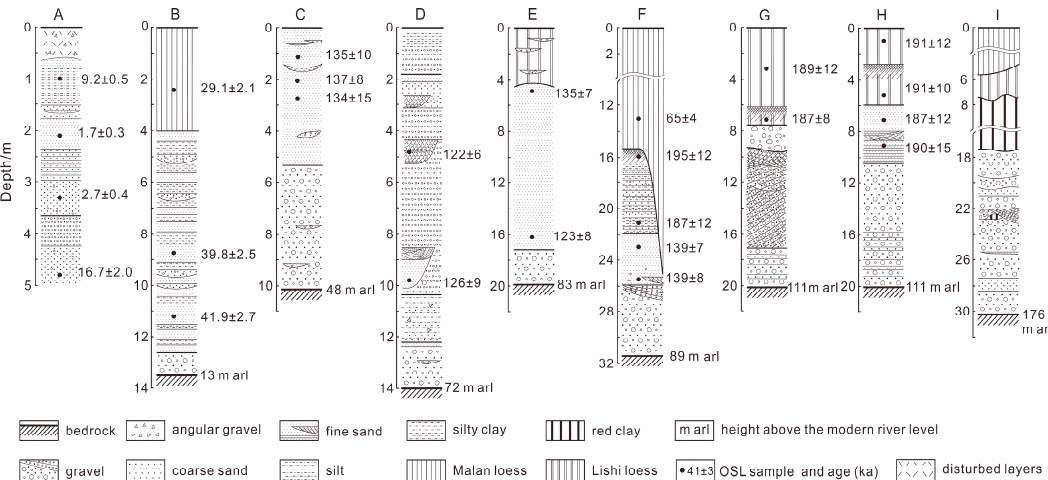
Figure 2. Stratigraphic columns of the terrace deposits in outcrops (A–I) marked in Figure 1c, and the positions of optically stimulated luminescence (OSL) samples and ages in ka. The elevations of bedrock surfaces (strath surface) above the modern river are displayed.